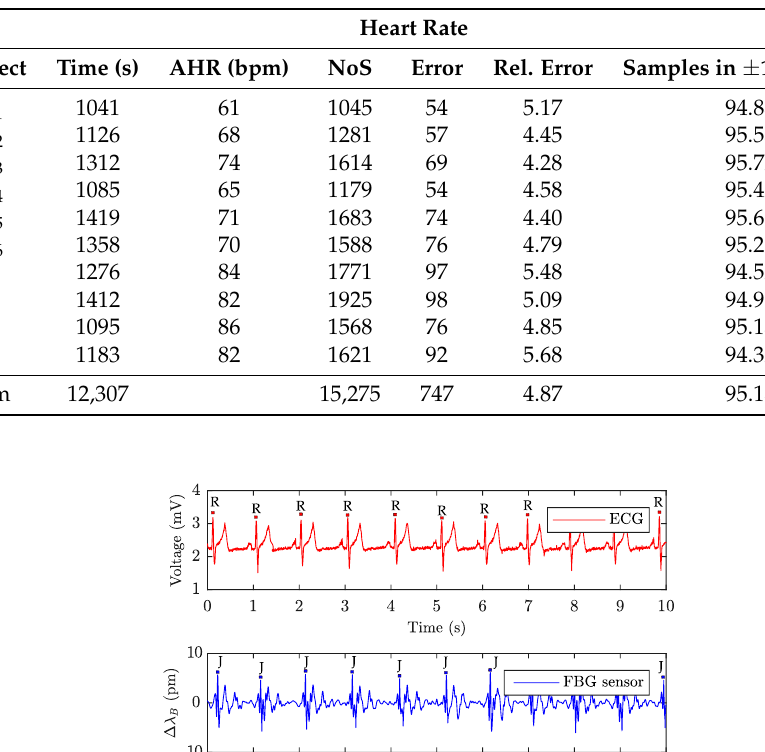
Table 3. Summary of heart rate measurements.